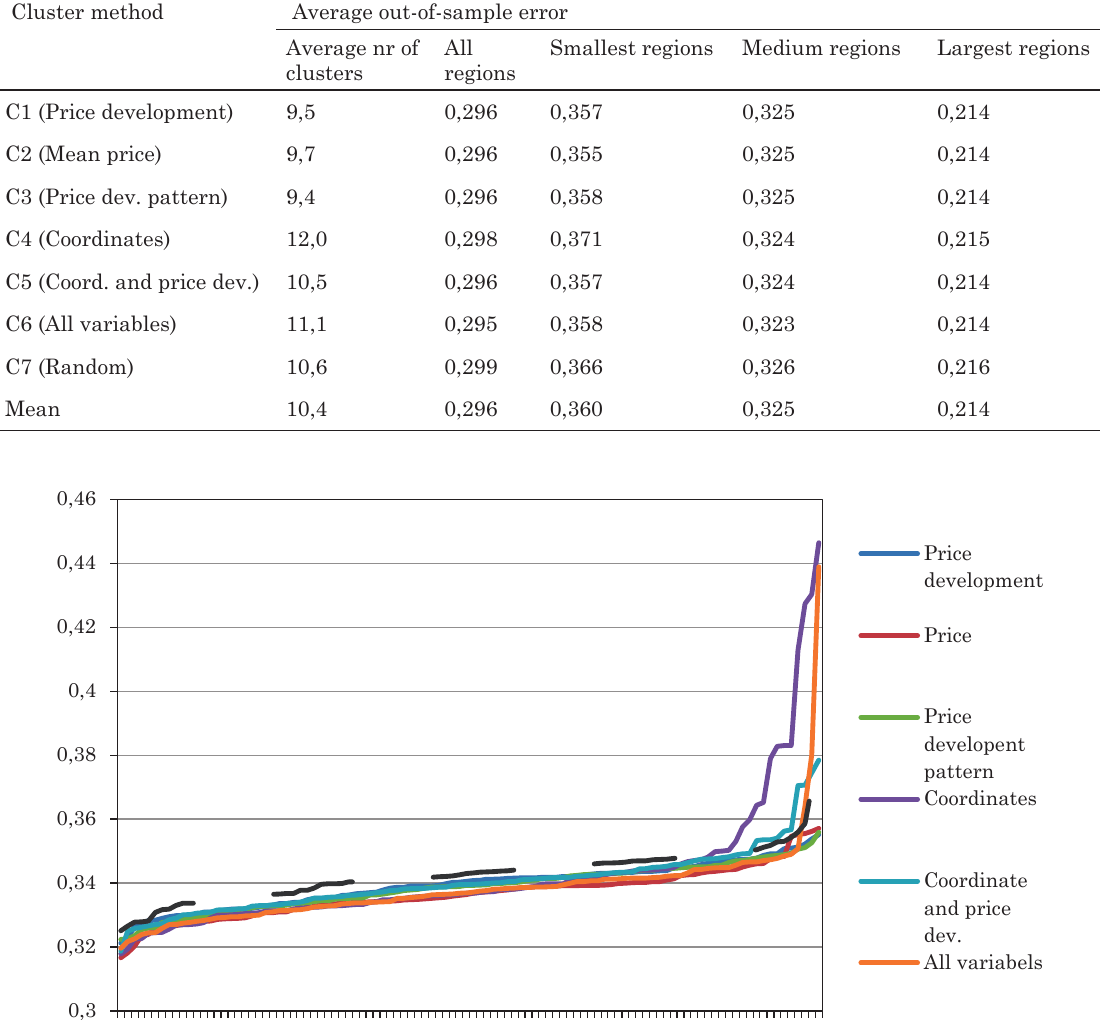
Coordinate and price dev. All variabels